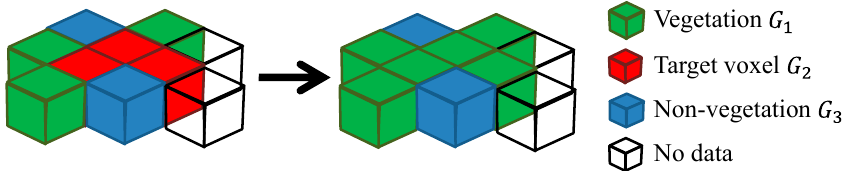
Figure 7. Classification of voxels based on continuity. Target voxels are changed into vegetation ones.